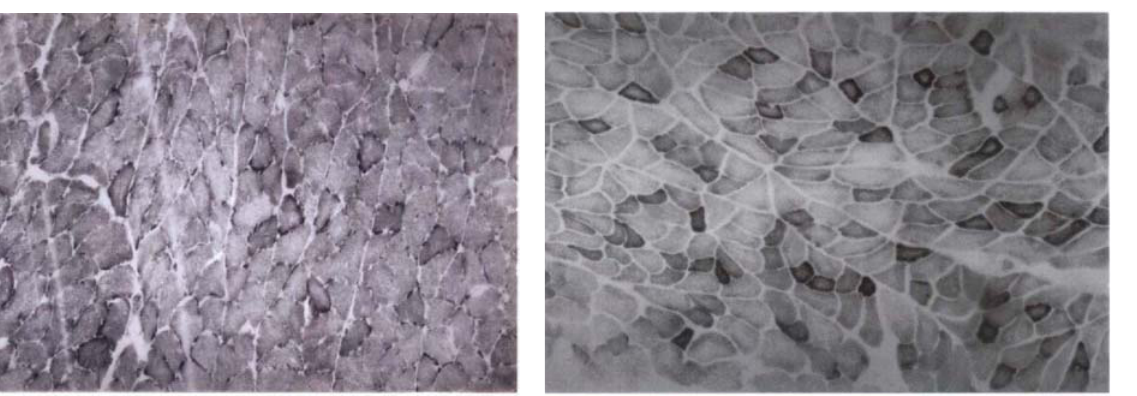
Figure 5a. NADH stain, soleus muscle, 18-month old underfed. Figure 5b . SDH stain, soleus muscle, 10-month old, sedentary.